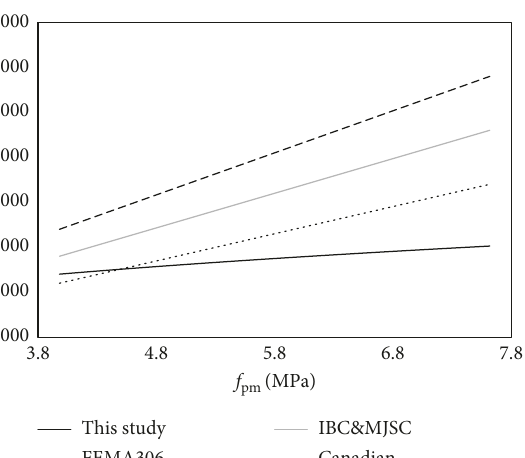
Figure 10: Regression analysis for ε